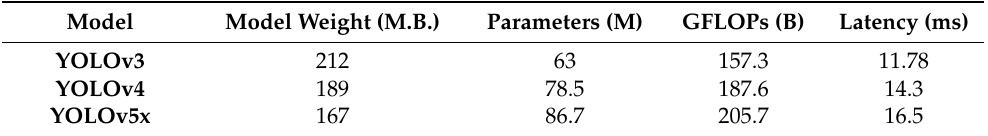
Table 3. Architectural Comparison between Different YOLO